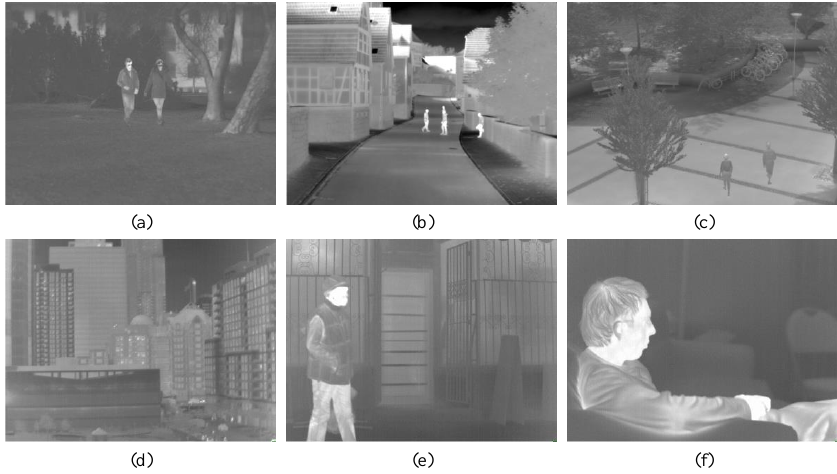
Figure 2. HR infrared images: ( a ) birds, ( b ) streets, ( c ) crossroads, ( d ) building, ( e ) passerby, and ( f )